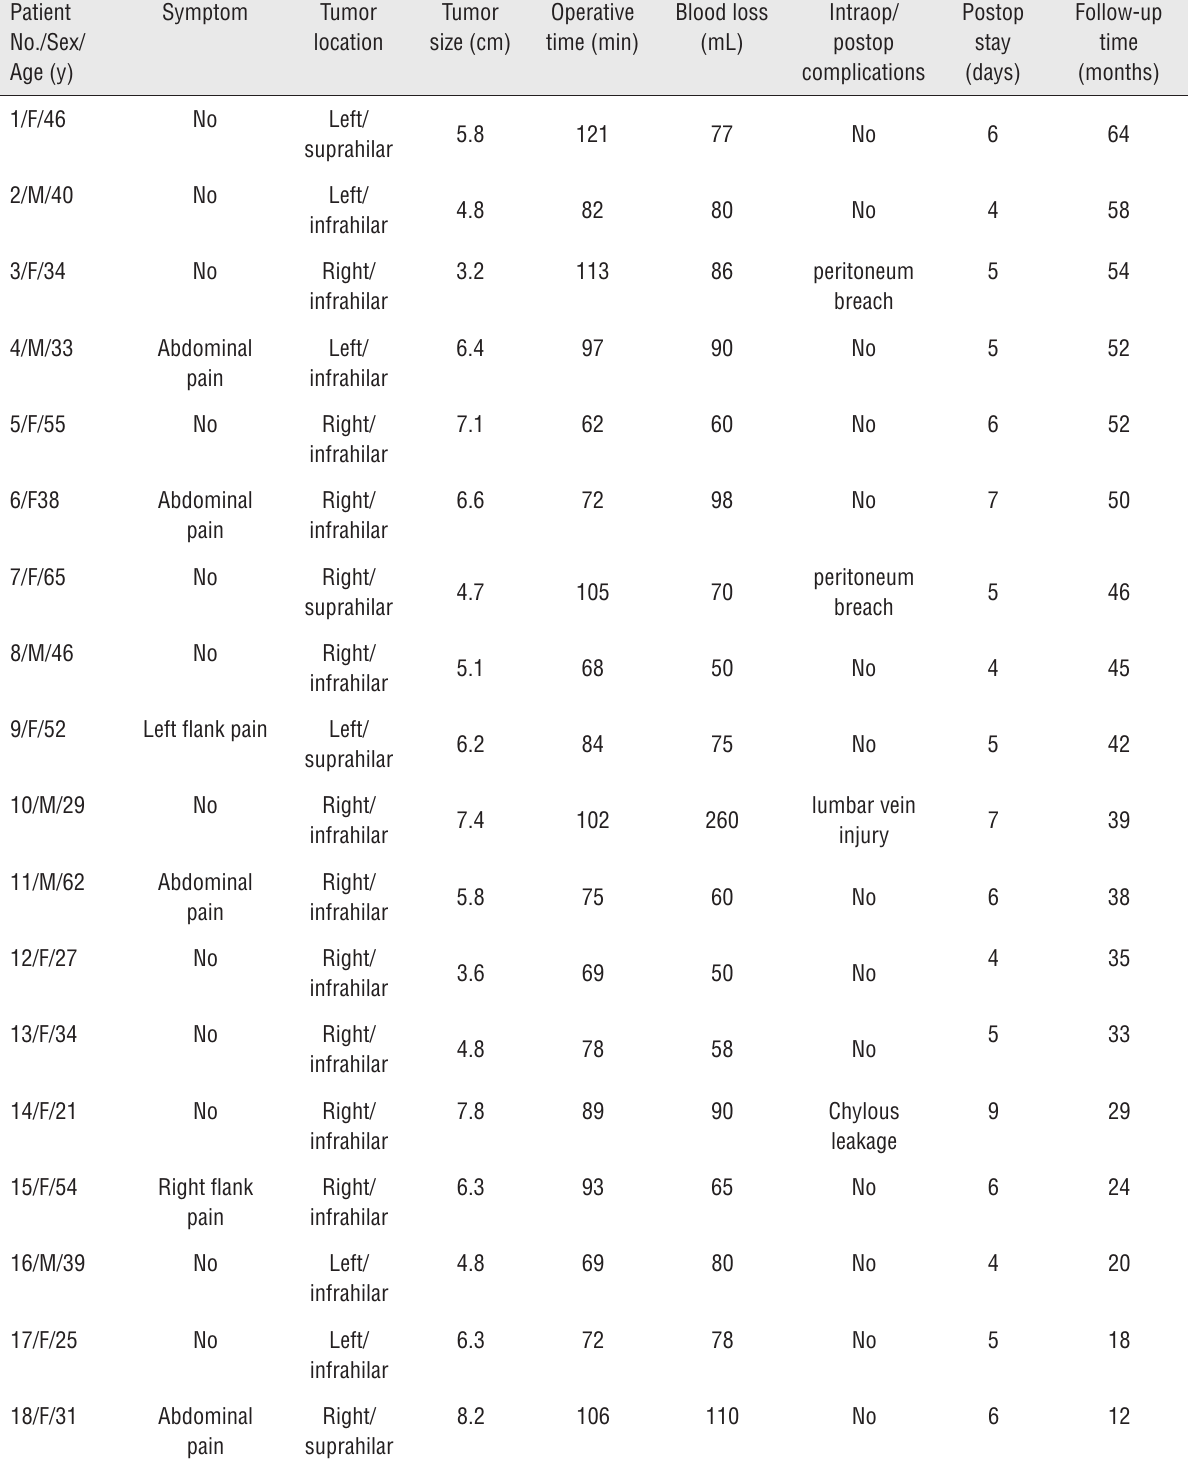
Table 1 - Patients’ characteristics and surgical